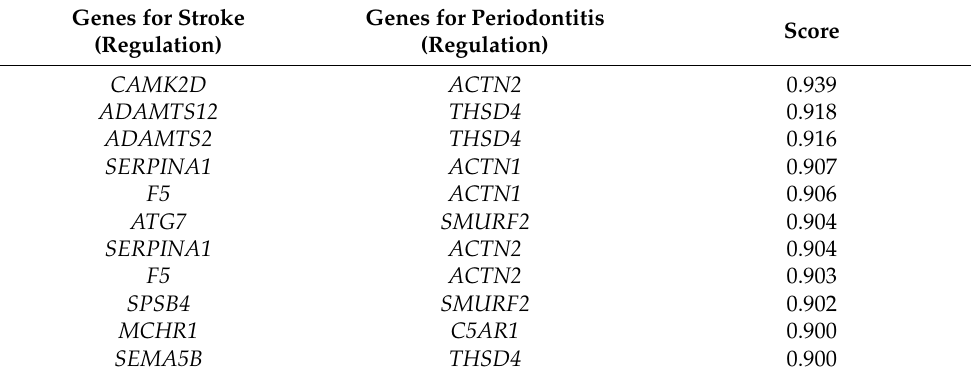
Table 1. Interaction weight between stroke and periodontitis genes identified in the